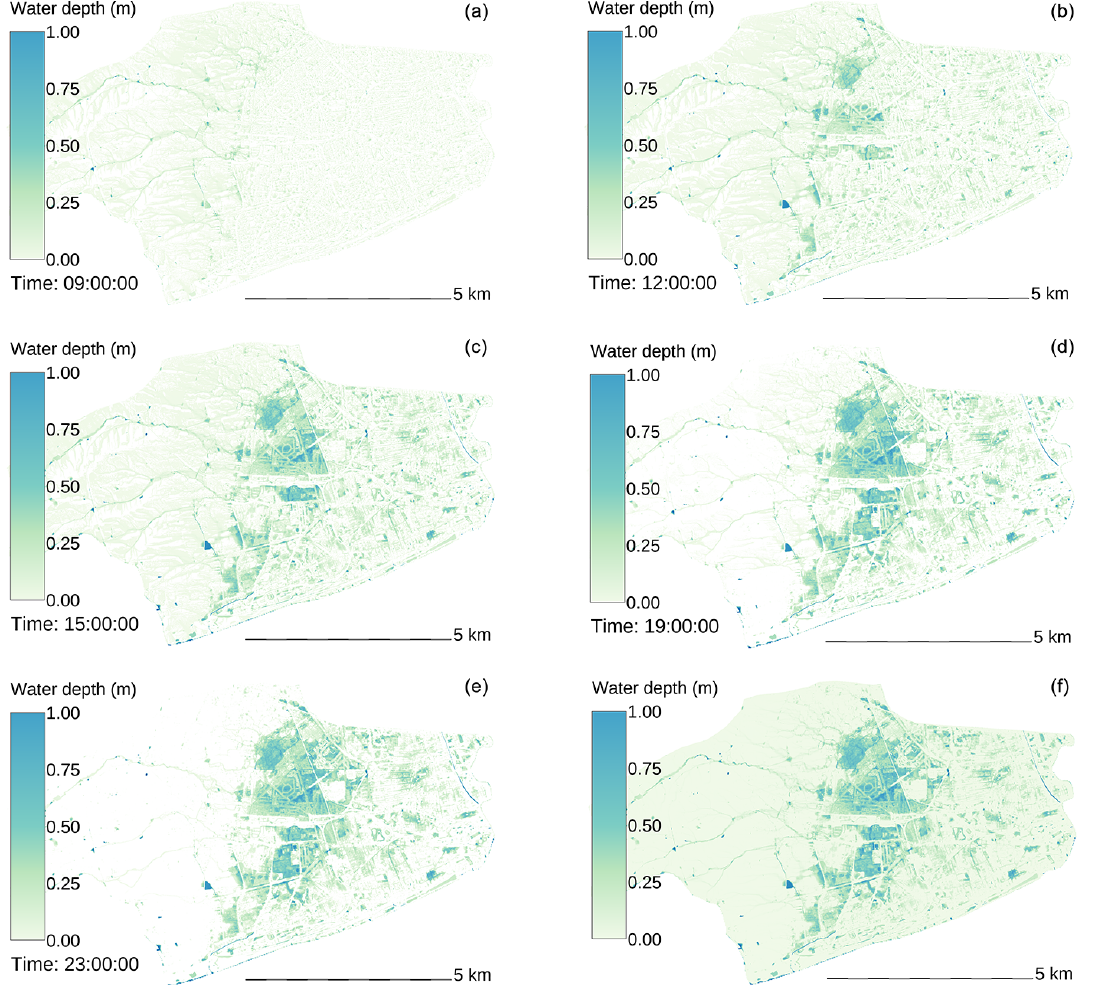
Figure 13. Water depth in Hull. Panels (a) to (e) show the evolution of water depth (m). Panel (f) shows the maximum water depth (m).